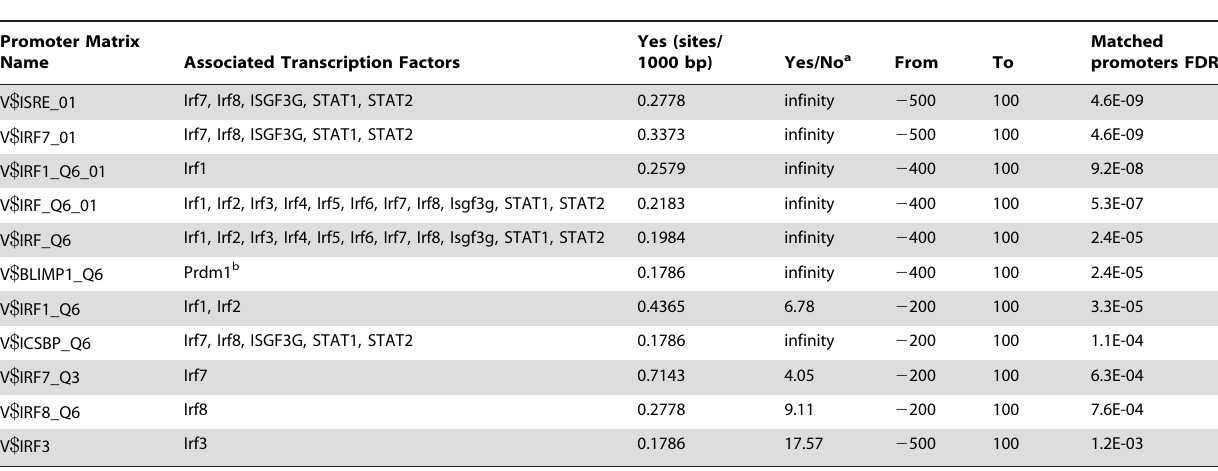
Table 4. Top eleven promoter regulatory matrices identified using the F-match module in ExPlain 3.1 (BioBase Knowledge Library) (see